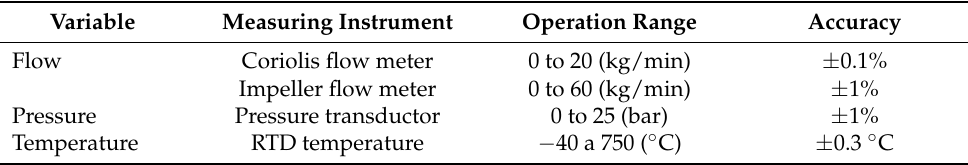
Table 1. Sensors summary